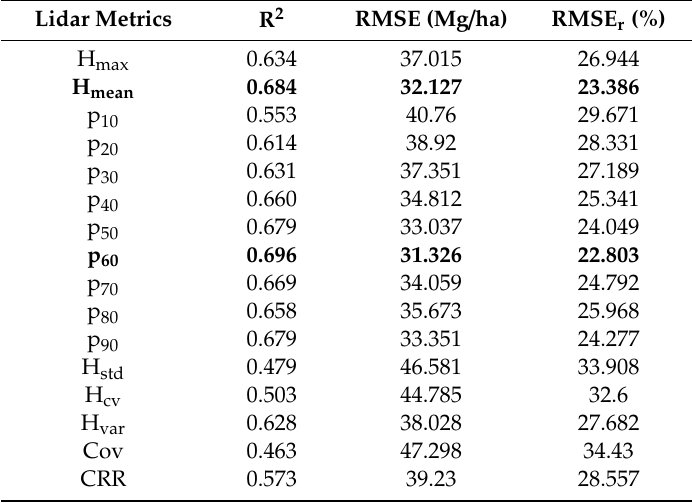
Table 4. Accuracy assessment of the models with input variables of LiDAR